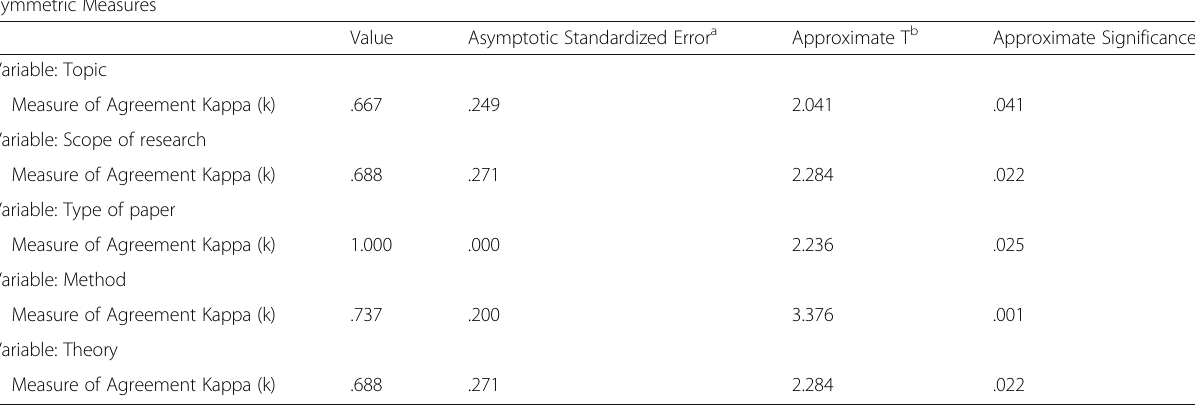
Table 9 Intercoder agreement for the different variables: Cohen ’ s Kappa tests Symmetric Measures Value Asymptotic Standardized Error